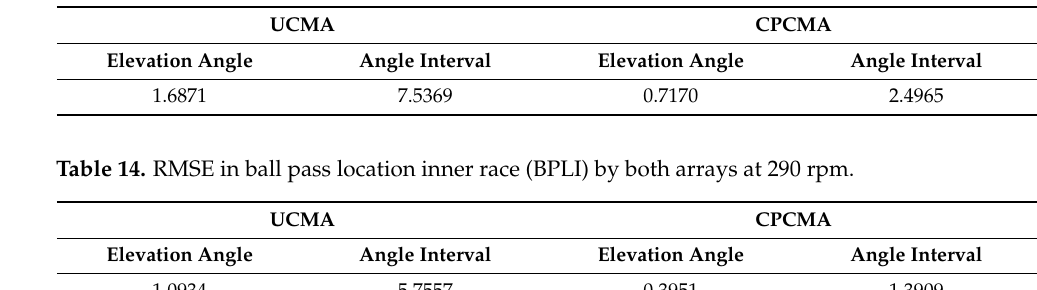
Table 13. RMSE in ball pass location outer race (BPLO) by both arrays at 290 rpm.